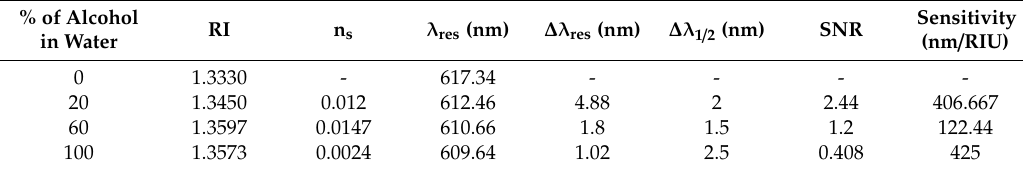
Table 3. Cu–SPR sensor: sensitivity and SNR comparison.